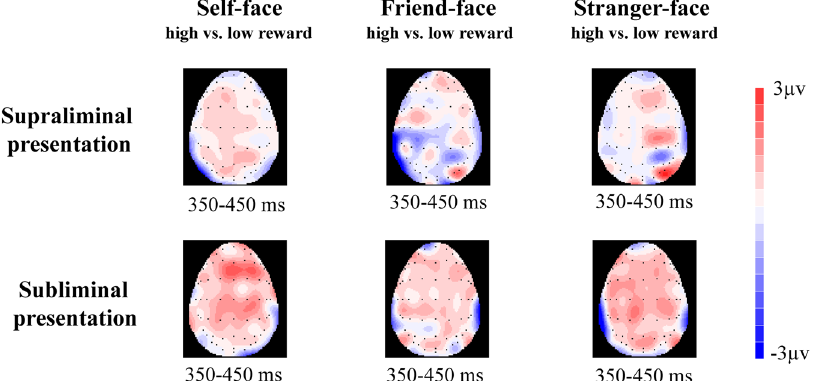
Figure 2. Averaged event-related potentials (ERPs) at Cz, Pz, and PO8 for self-face, friend-face and stranger- face as a function of reward presetation types and values of reward. The gray shaded areas on figure indicated the prominent ERPs components in its specific given time range,